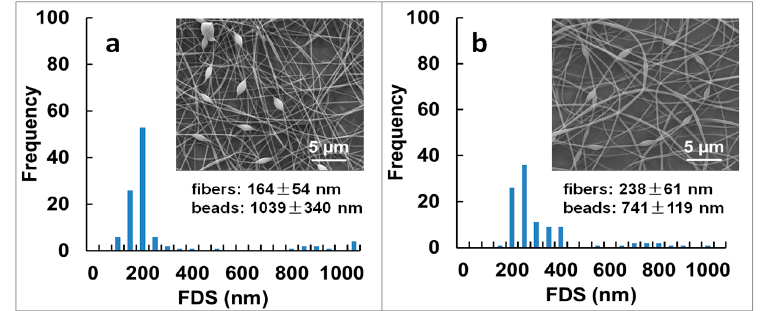
Figure 5. SEM images and fiber diameter size (FDS) of electrospun nanofibers prepared at 8 wt % PVA concentration and reinforced with ( a ) TA-Fe +++ (III) and ( b ) TA-Fe +++ (I) complexes.